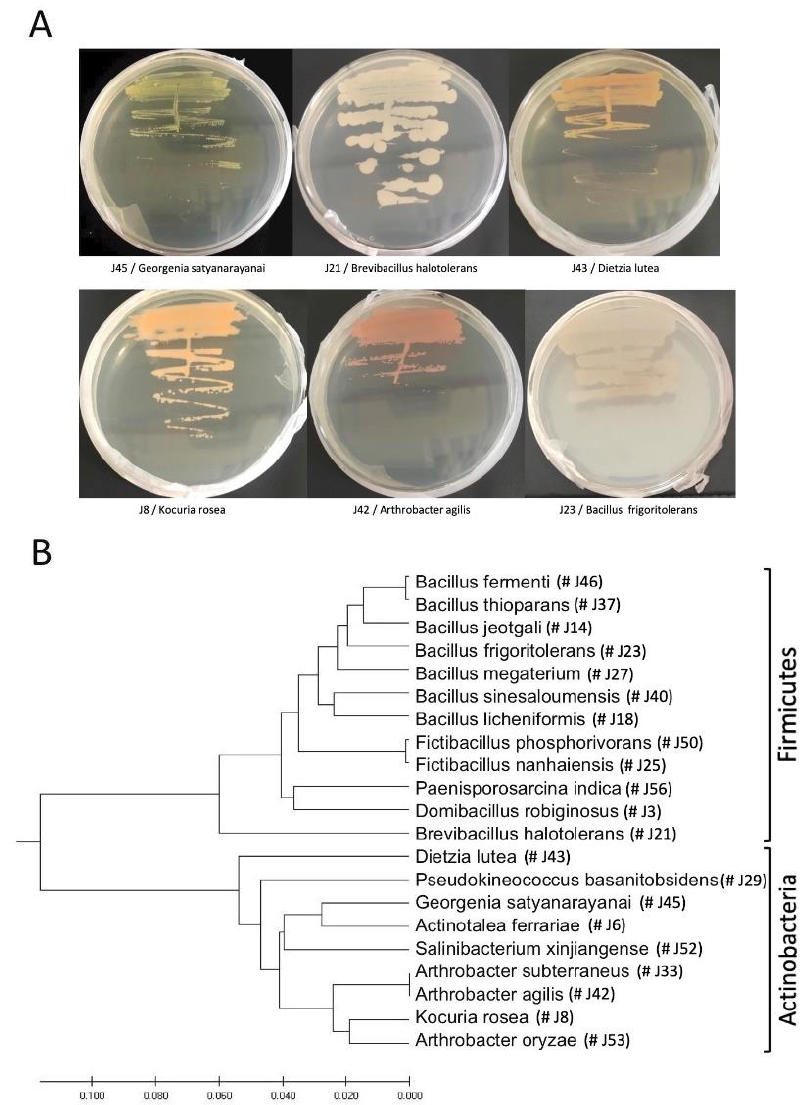
Figure 2. Isolation of endophytes from Z. dumosum petioles on nutrient agar plates. ( A ) Examples of endophytic bacteria producing colors. ( B ) Phylogenetic relationship of the endophytic bacteria iso- lated from petioles dividing the identified endophytes into two phyla, Firmicutes and Actinobacte- ria.